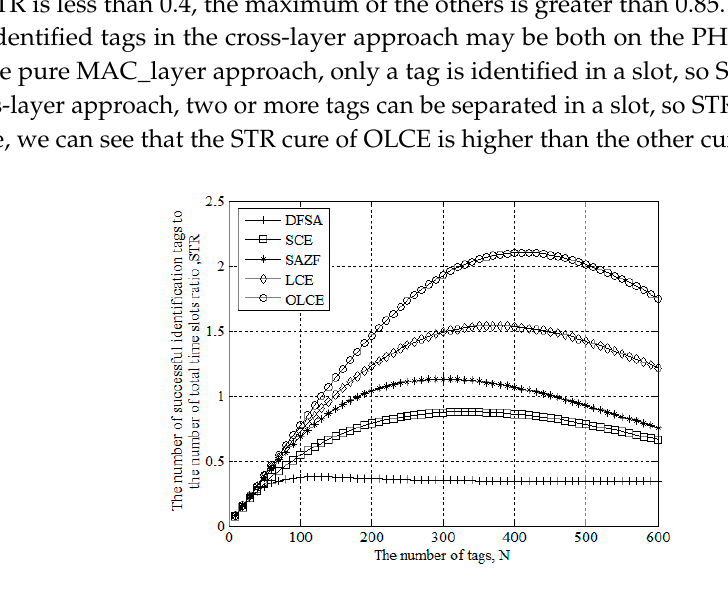
Figure 9. STR for DFSA, SCE, SAZF, LCE, and OLCE under different the number of tags when SNR is 20 dB.